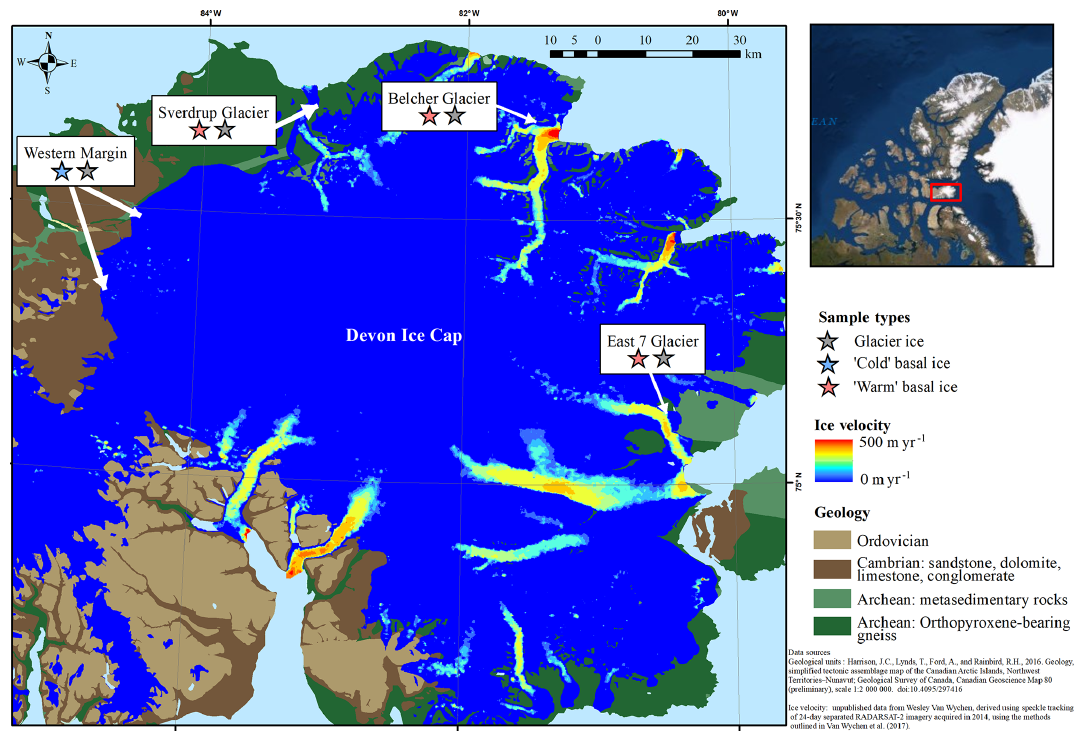
Figure 1. Study site indicating the geology of the surrounding substrate and flow velocity of the Devon Ice Cap. Samples were collected from three polythermal glaciers with relatively fast-flowing ice that are surrounded by Archean bedrock and two locations along the relatively slow-flowing cold-based section of the western